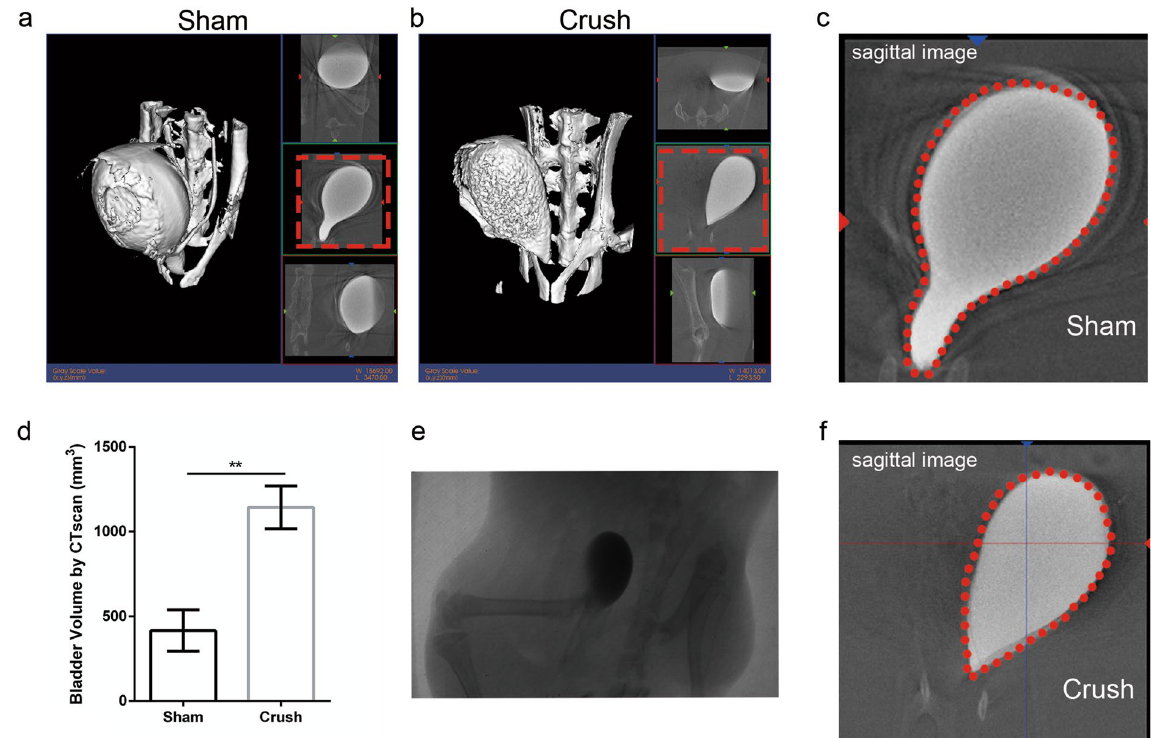
Figure 4. CT reconstruction of bladder and calculated volume. ( a and b ) 3-dimensional reconstruction of contrast media filled bladder of two groups, right inset images were axial, sagittal and coronal images from top to bottom, respectively. ( c ) CT fluoroscopy showed the real-time image of bladder. ( d and e ) Sagittal image of the contrast media filled bladder. ( f ) Bladder volume calculated by CT scan, N = 4/group. Data was represented as mean ± SEM. Significance levels were set at ** P <